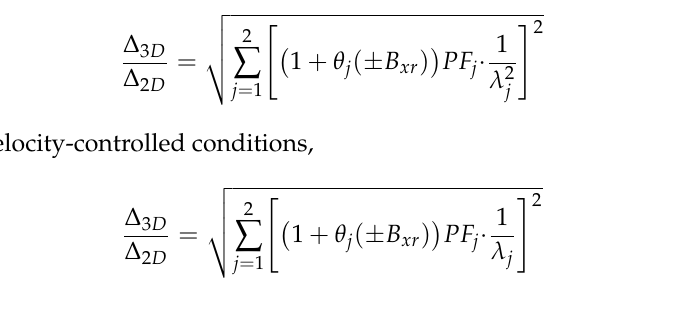
Figure 2. Single-storey building model featuring asymmetry subjected to y-directional spectral loads.